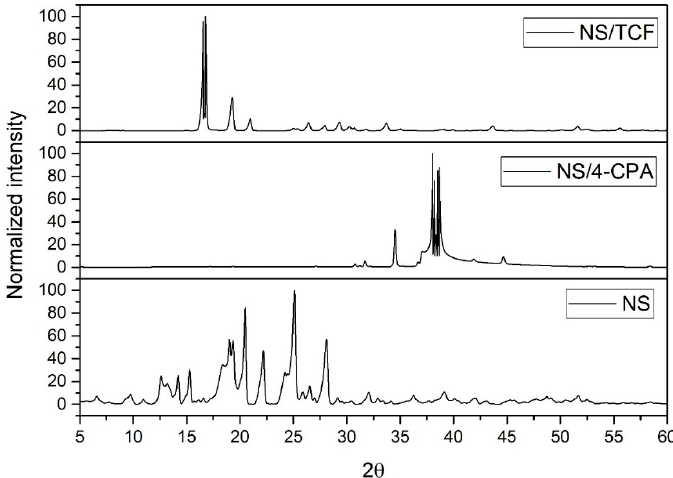
Figure 2. X-ray powder diffraction (XRPD) analysis for nanosponges (NS) and NS–pesticide complexes.